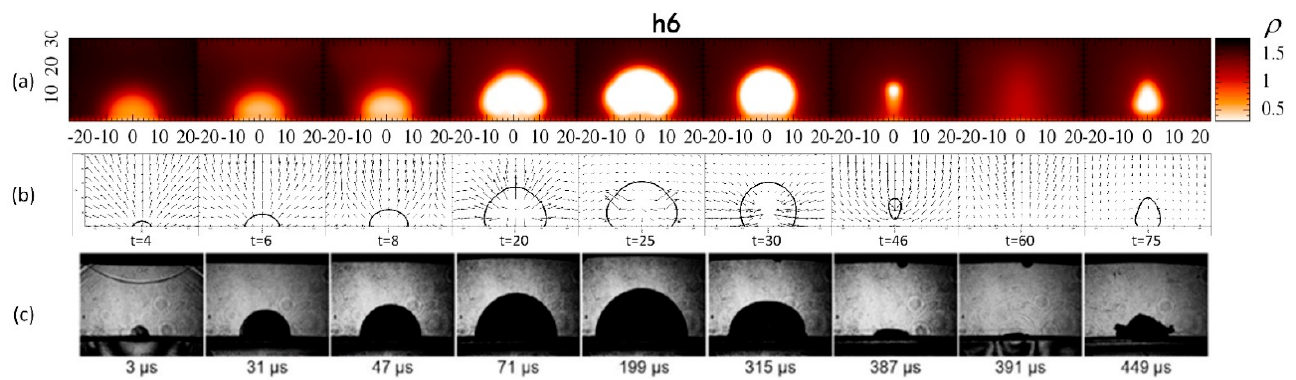
Figure 11. ( a ) Bubble density contour and ( b ) flow field vector for Case h6 with η = 1.8. ( c ) Bubble images in the Nguyen experiment with h = 4 mm, corresponding to η = 1.6 by their maximum bubble radius [35]. The white part in ( a ) is the vapor phase, and the shadow part in ( c ) is also the vapor phase.